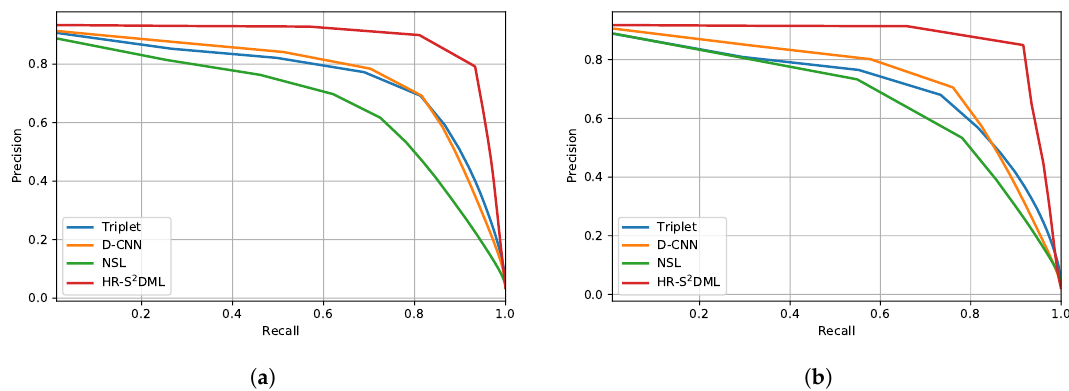
Figure 5. PR curves describing the image retrieval performances of the considered methods in AID ( a ) and NWPU-RESISC45 ( b ), when the percentage of the labeled images is 20%. Note that test sets serve as external queries, whereas the training sets are used as retrieval databases.